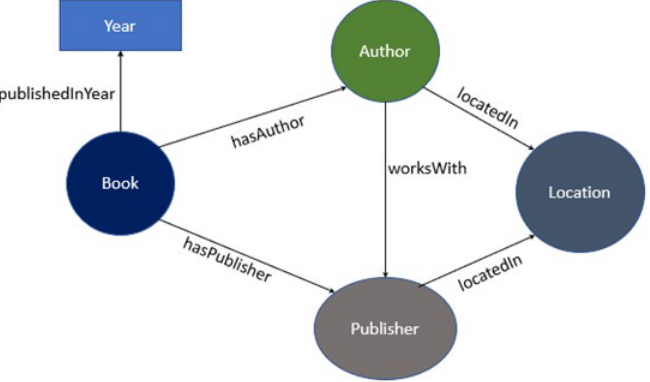
Figure 1. Illustration of ontology defining the generalized concepts and their relationship.